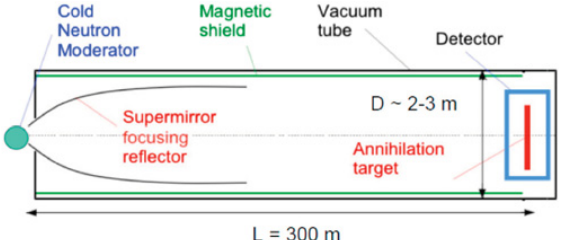
Figure 2. A simplified model of a cold neutron beam experiment at the large beam port at the ESS (NNBar@ESS). The projected ultimate sensitivity, after 3 years of running, is from 200 to 600 times that of the original experiment, depending on the details of the shielding optimization near the ESS moderator, using the current cold source design.